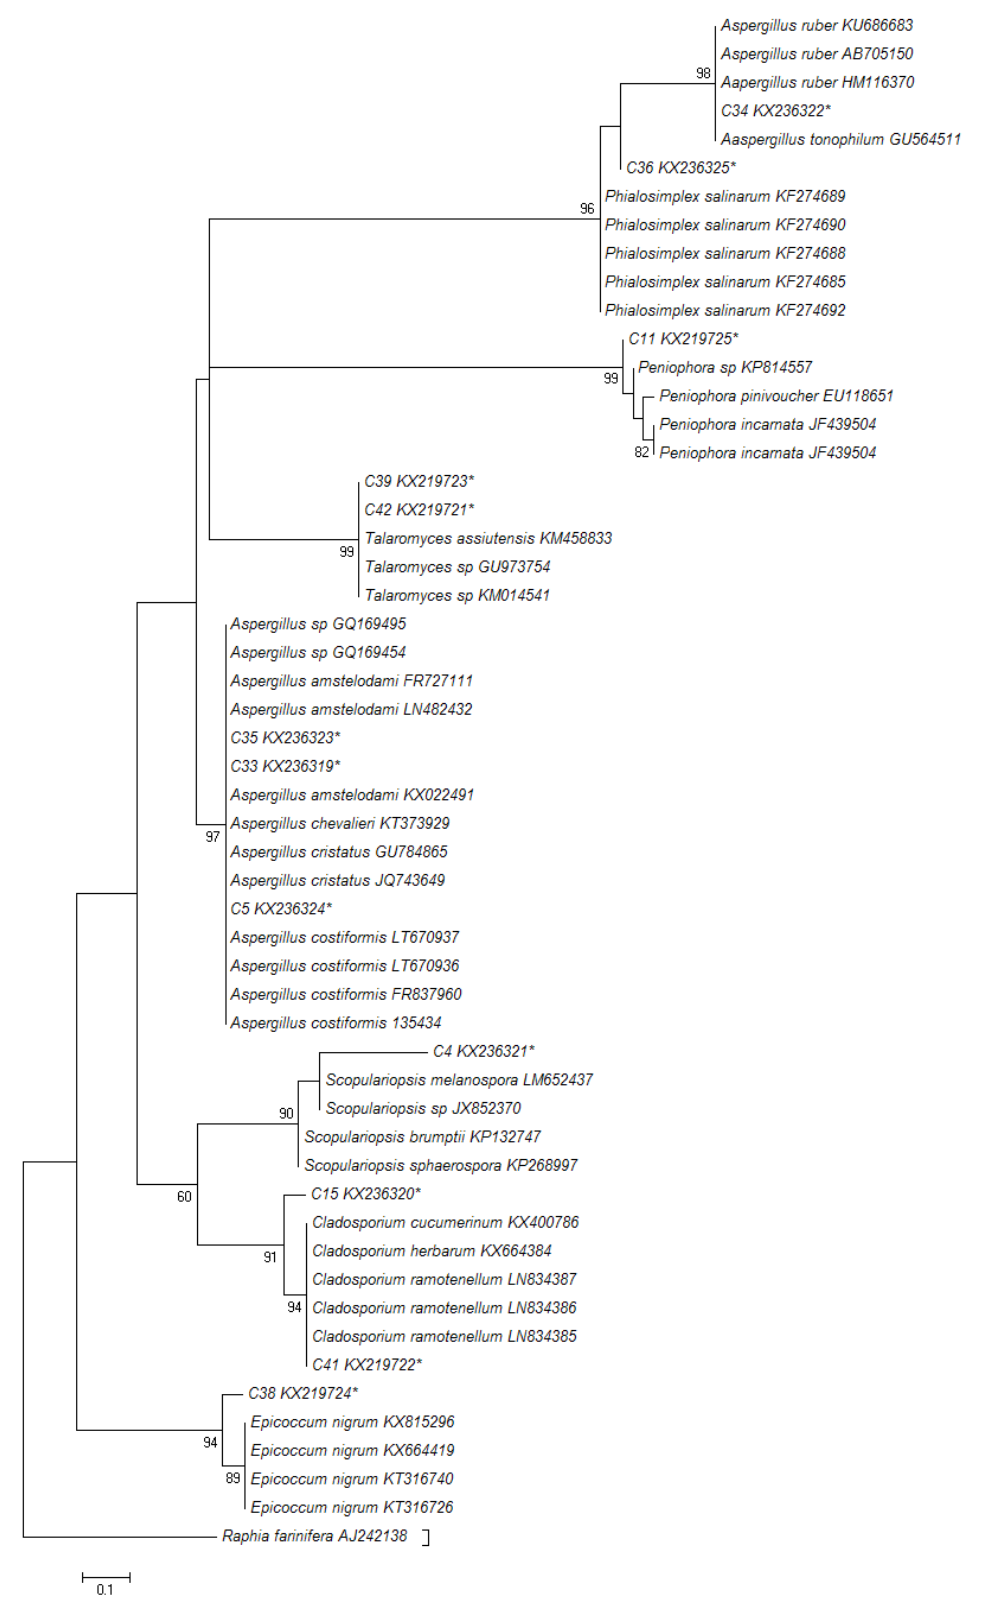
Figure 1: Phylogenetic tree based on the maximum likelihood method from the strains amplified by the primers ITS1-ITS2. * Strains isolated in this study. Bootstrap values are expressed as